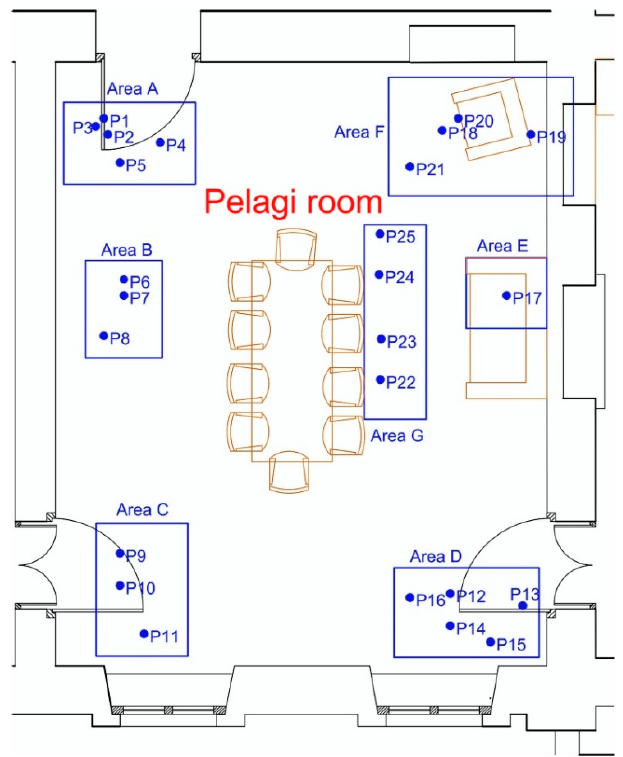
Figure 7. Survey area on the Pelagi room vault.